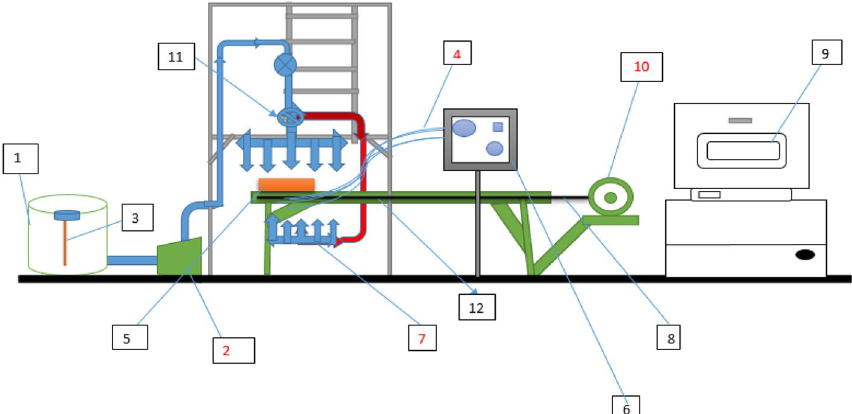
Fig. 2 Schematics of the modified ROT set-up plant: 1, water tank; 2, electric pump; 3, heater; 4, thermocouple wires; 5, the workpiece and its carrier; 6, thermocouple control panel, workpiece bed; 7, bottom impingement nozzle; 8, motorized screw conveyor; 9, furnace; 10, electric motor; 11, flow valve/air attachment nozzle; 12, flow meter; 13, ladder; 14, furnace support; 15, PVC pipes; 16, pressure gauge,